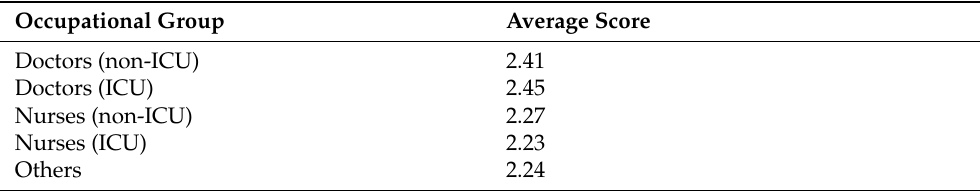
Table 4. Average scores on the help-seeking inhibition